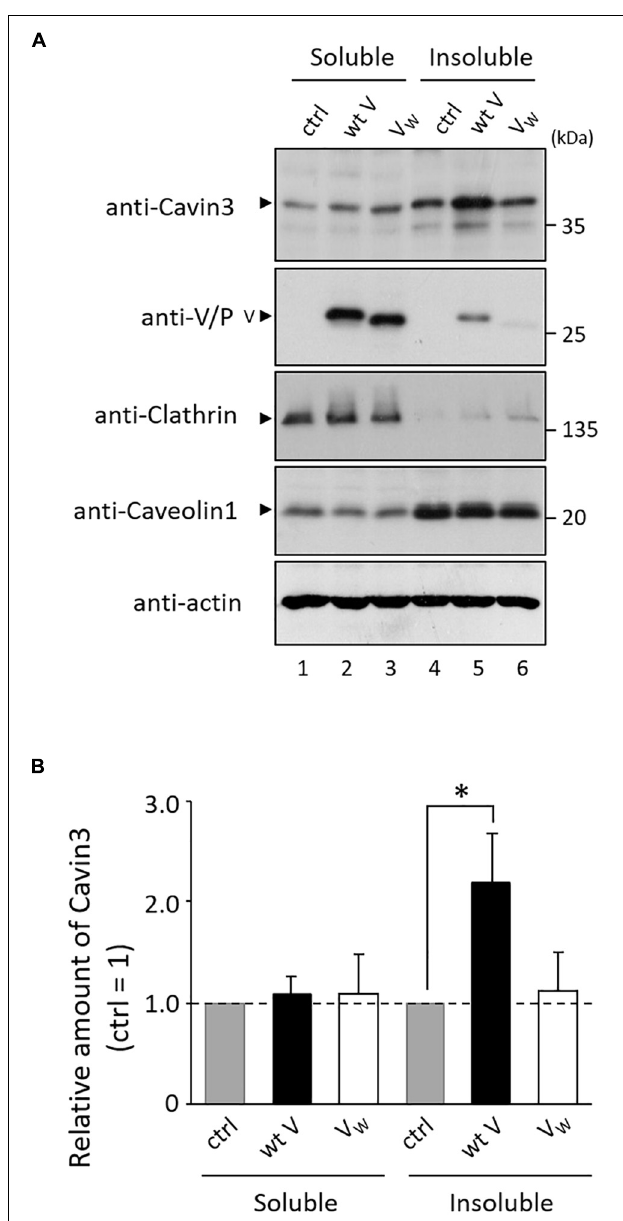
FIGURE 6 | Effects of hPIV-2 infection on Cavin3 expression in lipid raft. (A) HeLa/ctrl, HeLa/wt V, and HeLa/V W178H / W182E / W192A (HeLa/V W ) were extracted with 1% TritonX-100 at 4 ◦ C, and soluble and insoluble fractions were prepared as described in the Materials and Methods section. Cells were subjected to immunoblot using the indicated Abs. Clathrin and Caveolin1 were used as non-raft and raft markers, respectively. Actin was used as a loading control. (B) The quantitative densitometry of Cavin3 was performed as described in Figure 2D . Data are shown as the relative value (HeLa/ctrl = 1). * P < 0.05, compared to values of HeLa/ctrl. Error bars indicate standard deviations. All experiments were performed three times independently.